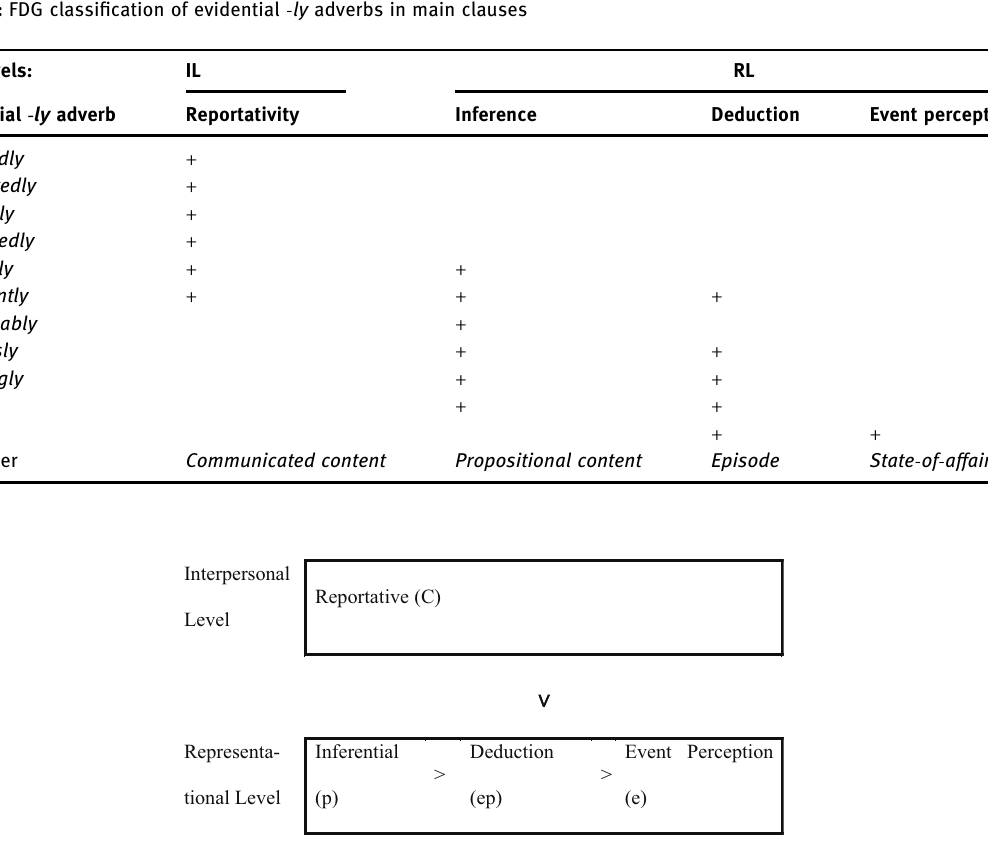
Figure 3: Hierarchical relations between evidential categories.